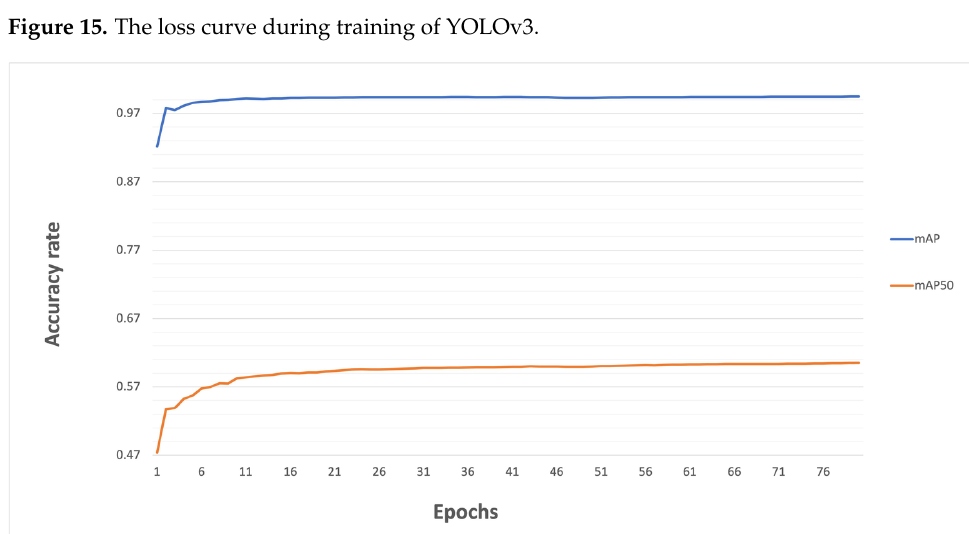
Figure 15. The loss curve during training of YOLOv3.